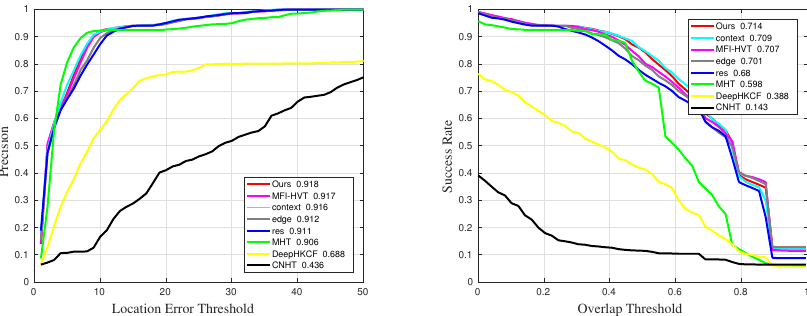
Figure 18. Precision and success rate under BC challenge.